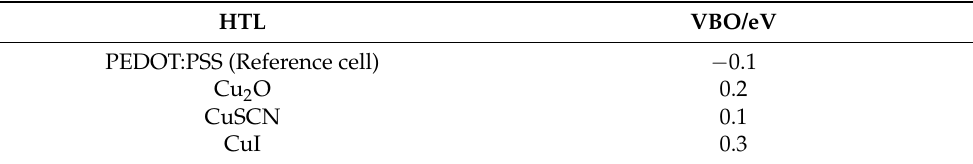
HTL materials are grouped in Table 5. Table 5. Valence band offset for the HTL